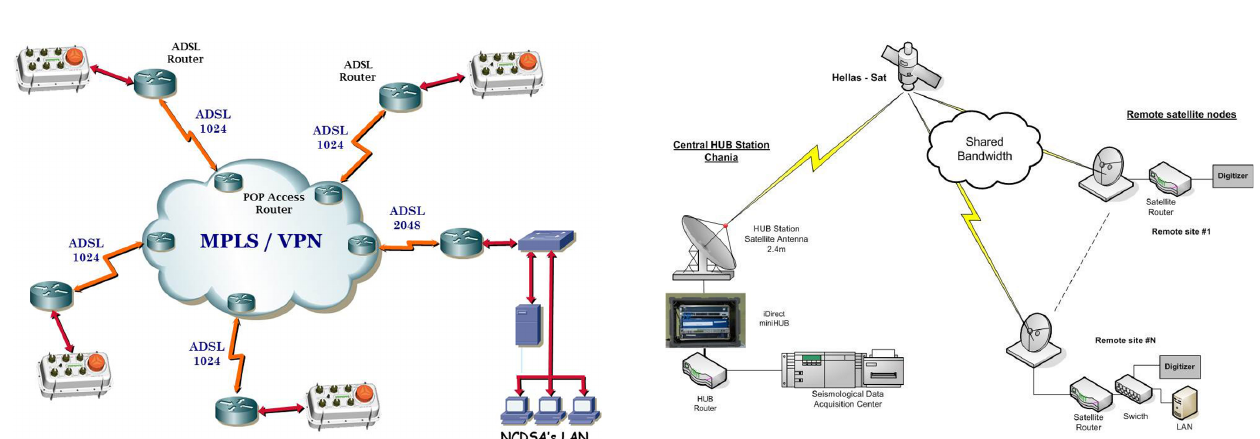
Fig. 3. MPLS/VPN topology used by HSNC.